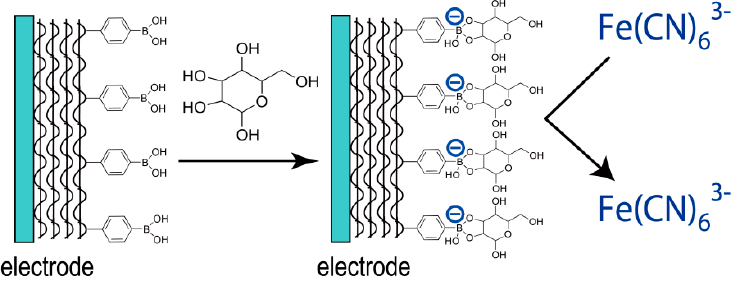
Figure 7. A schematic illustration of the response mechanism of PBA film-coated electrode sensitive to sugars.